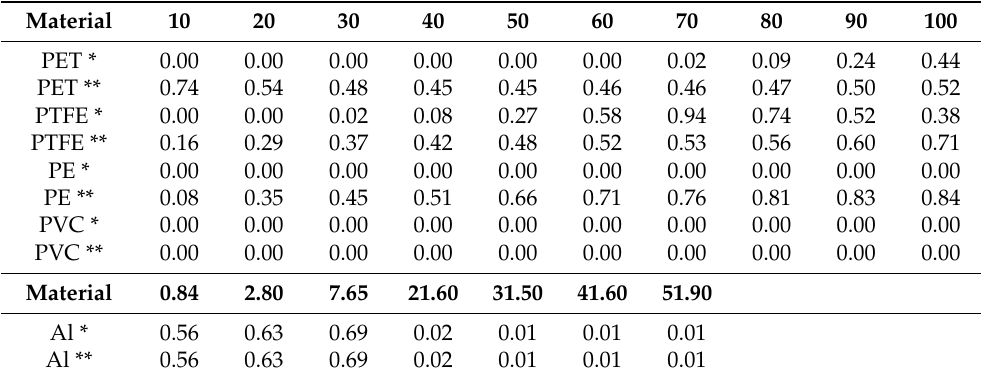
Table A1. The results of a Mann–Whitney ANOVA test showing for each material thickness the probabilities LAC to be closer to NIST one, before (*) and after (**) recalculation. Thickness (in bold) expressed in